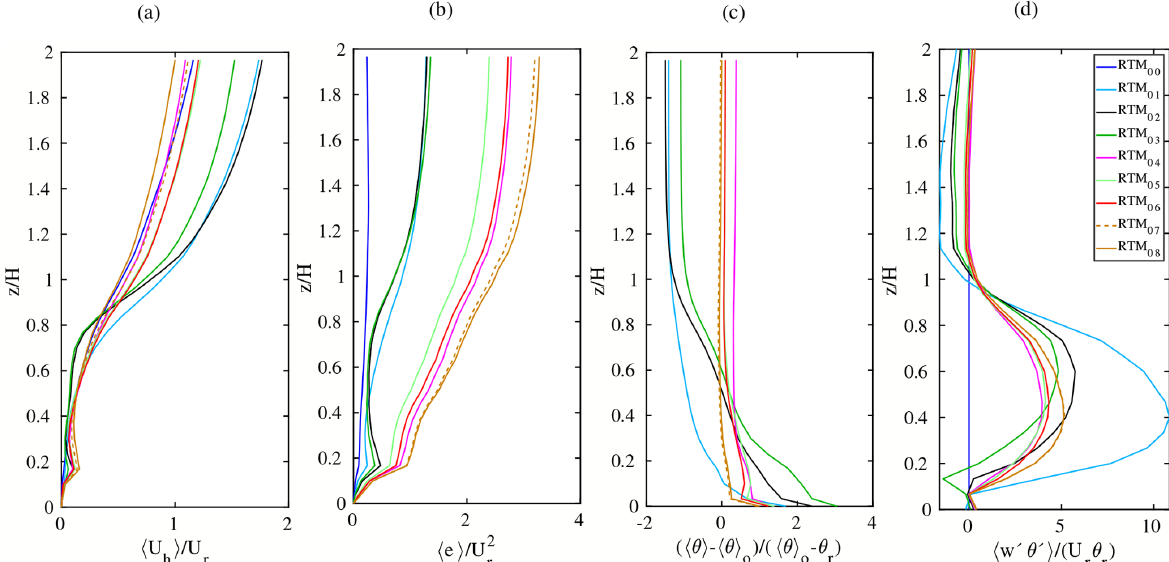
Figure 22. Horizontal- and time-averaged (1h) vertical profiles of the realistic urban configuration at 10:00LST of (a) horizontal wind speed (cid:104) u h (cid:105) = (u 2 + v 2 ) 1 / 2 , (b) turbulent kinetic energy (cid:104) e (cid:105) , (c) normalized vertical potential temperature (cid:104) θ (cid:105) deviation from the near-surface potential temperature (cid:104) θ 0 (cid:105) , and (d) normalized vertical turbulent flux of potential temperature (cid:104) w (cid:48) θ (cid:48) (cid:105) . Each quantity is normalized by its relevant combination of velocity ( U r ), temperature ( θ r ), and height scale ( H ). The reference velocity and temperature are the respective values at 2 H and the height scale is the mean building